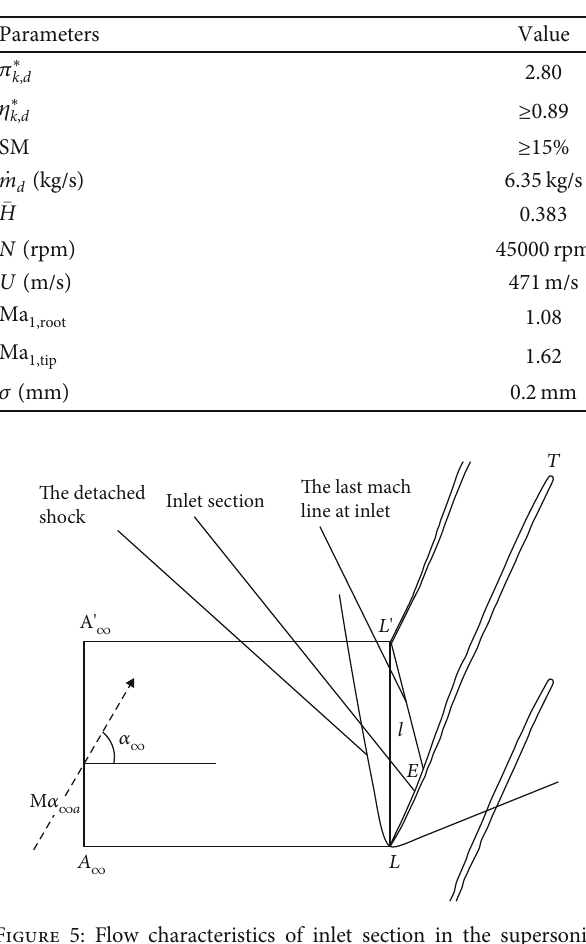
Table 1: Main parameters of supersonic rotor.